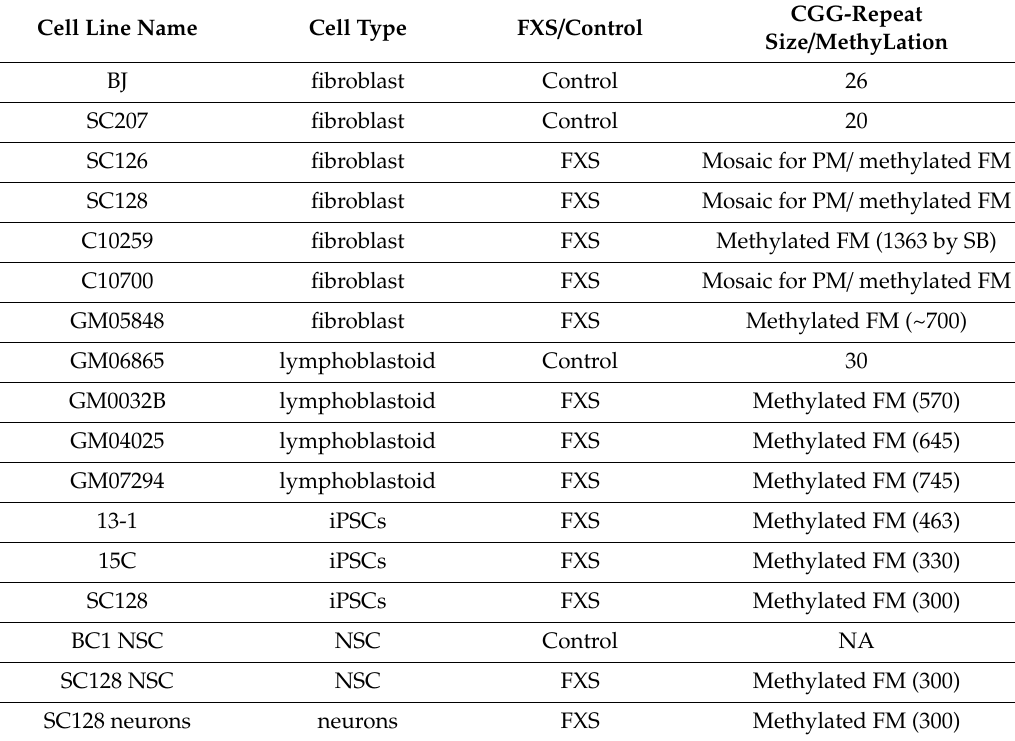
Table 1. List of cell lines used in this